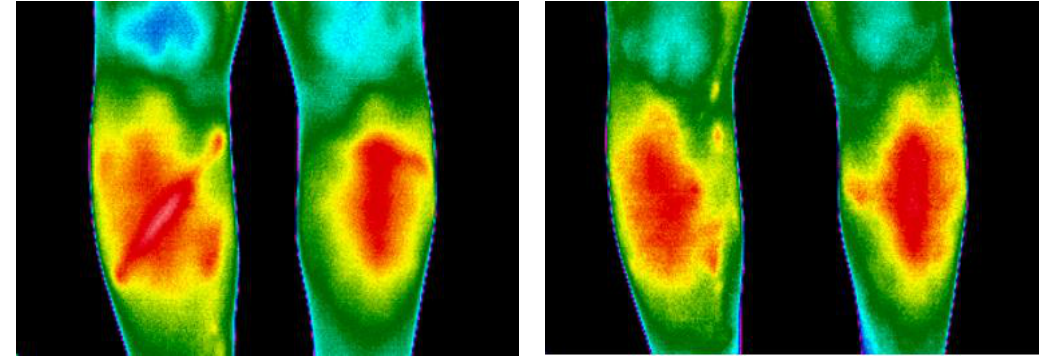
The incidence of soft tissue injuries such as muscle strains is relatively small in alpine skiing